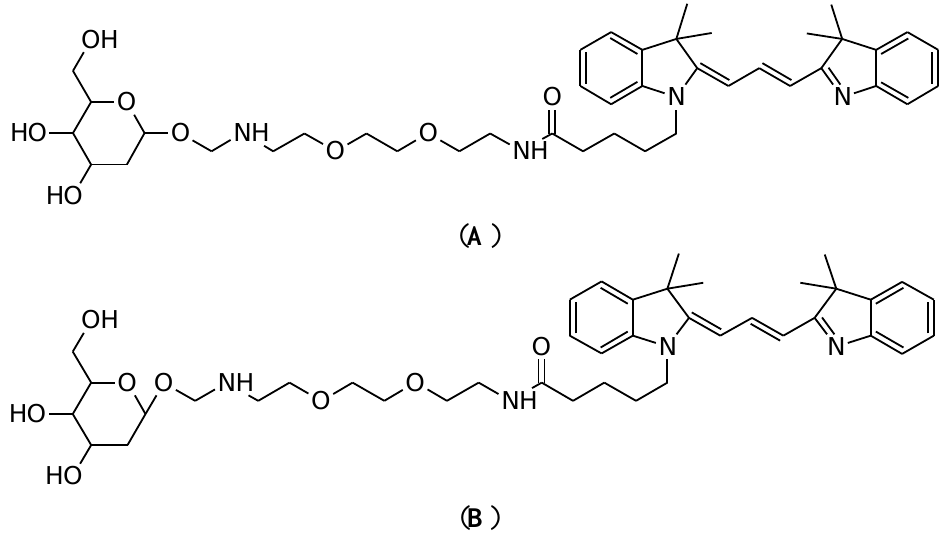
Figure 5. ( A , B ) Chemical structures of Cy3-linked O-1-glycosylatedglucose (Cy3-α-glucose (A) and Cy3-  -glucose (B)) developed by Park at Seoul National